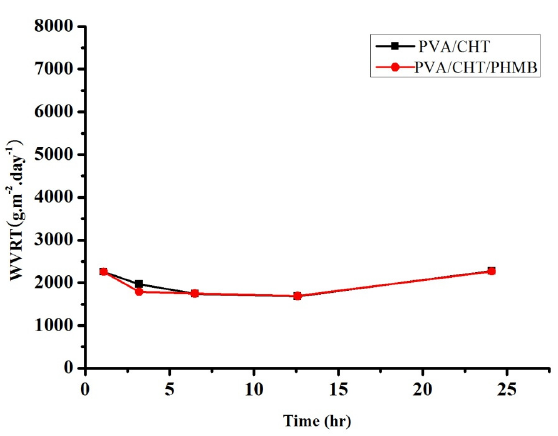
Figure 4. The WVTR of PVA/CHT/PHMB blends formed film.